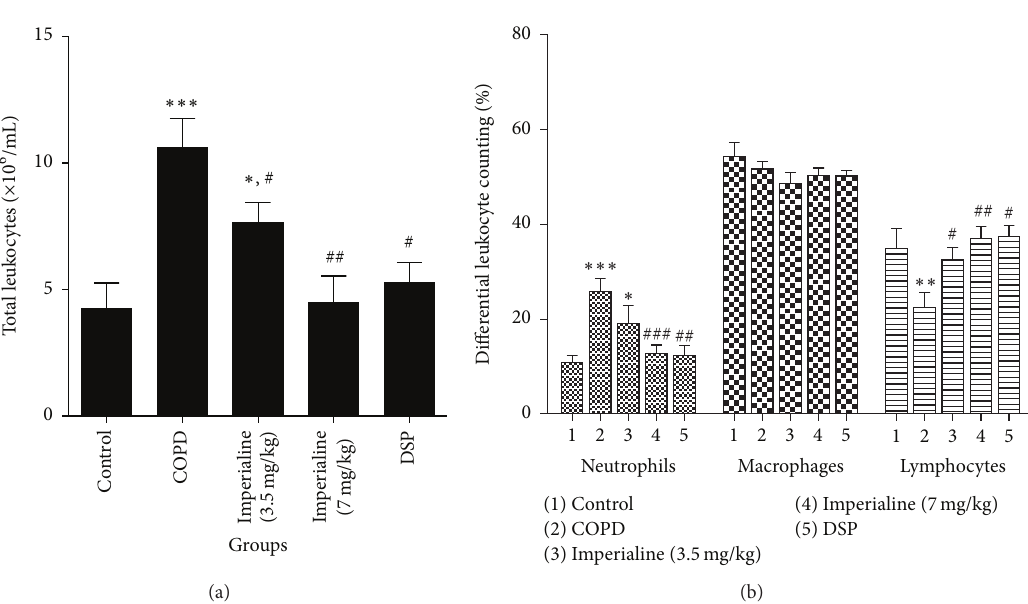
Figure 3: The effect of imperialine on (a) the total cell number of leukocytes and (b) the number of the different leukocytes in BALF. Results wereexpressedasthemean ± SEM( 𝑛 = 10 ).Significantdifferencescomparedwiththecontrolgroupweredesignatedas ∗ 𝑃 < 0.05 , ∗∗ 𝑃 < 0.01 , and ∗∗∗ 𝑃 < 0.001 . Significant differences compared with the COPD group were designated as # 𝑃 < 0.05 , ## 𝑃 < 0.01 , and ### 𝑃 < 0.001 .